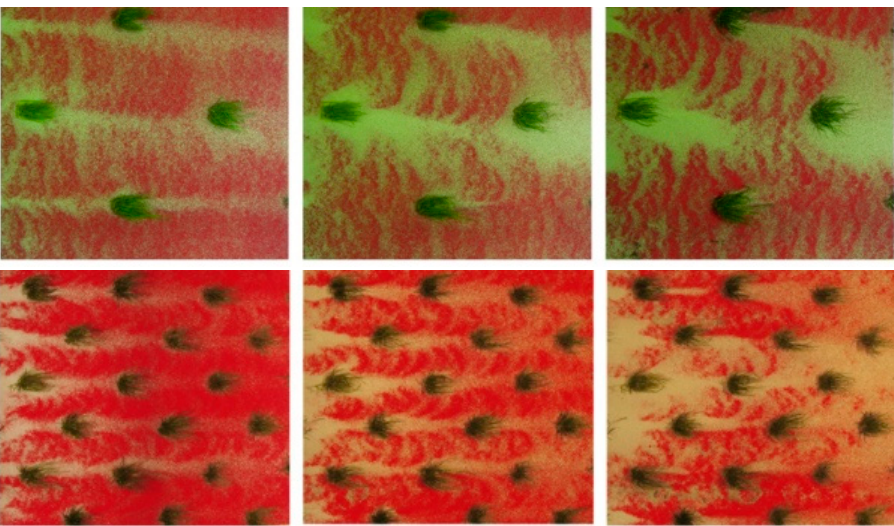
Figure 6. Image sequences of sediment deposition patterns in Suter-Burri et al.’s [60] wind tunnel experiments, on surfaces populated by low-density ( top row ) and medium-density ( bottom row ) canopies. White sand was blowing in from upstream, with wind direction from left to right (adapted from [60] (p. 69)).